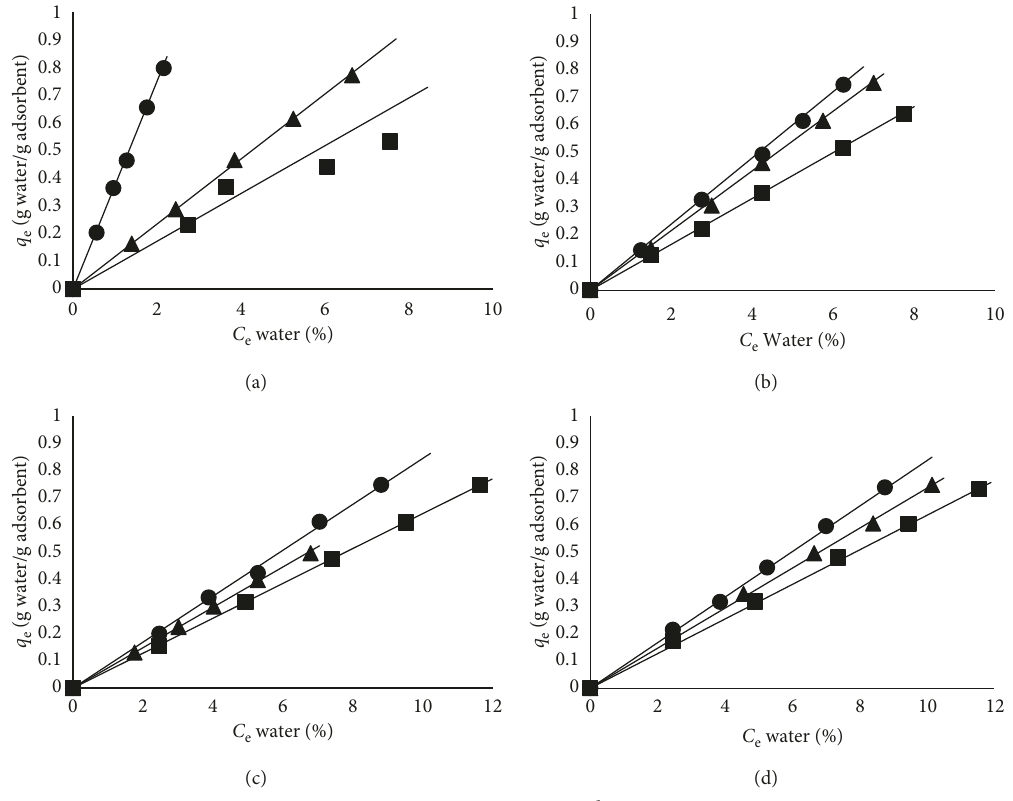
PVA/Zeo/AC 1:1:1; , eks PVA/Zeo/AC 1:1:0; , q eks mod